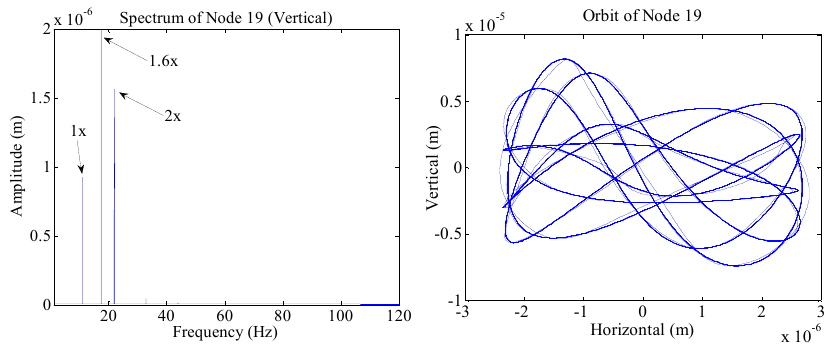
Figure 9. The spectrum and the orbit of Bearing 4 (misalignment at Bearing 1).